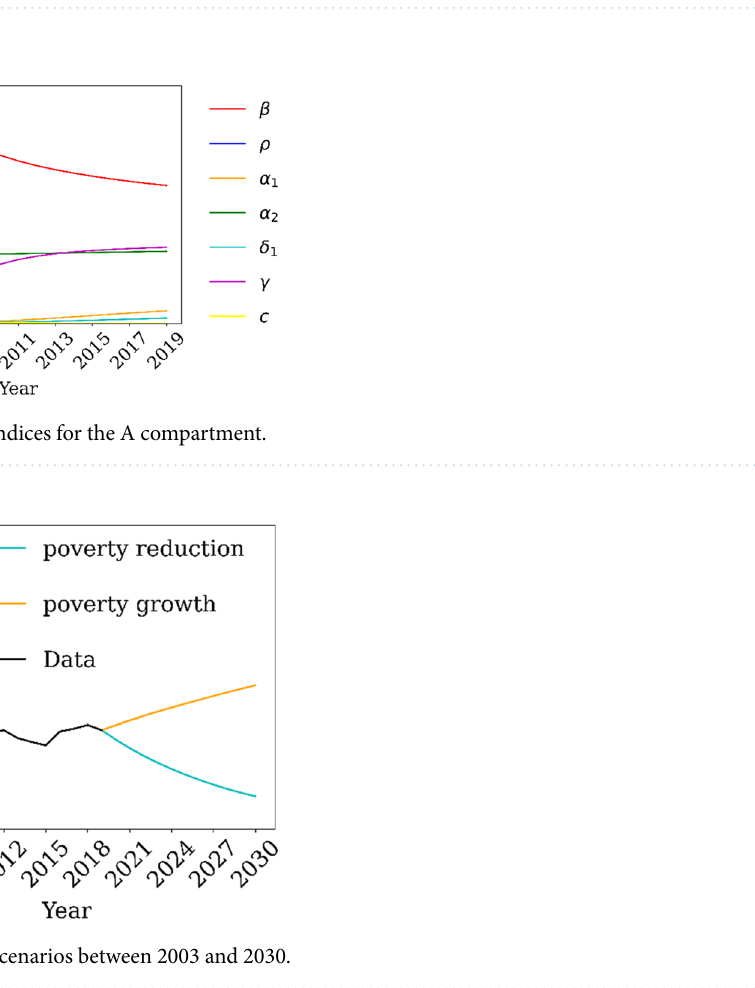
Table 1. Parameter description of the HIV/AIDS model.